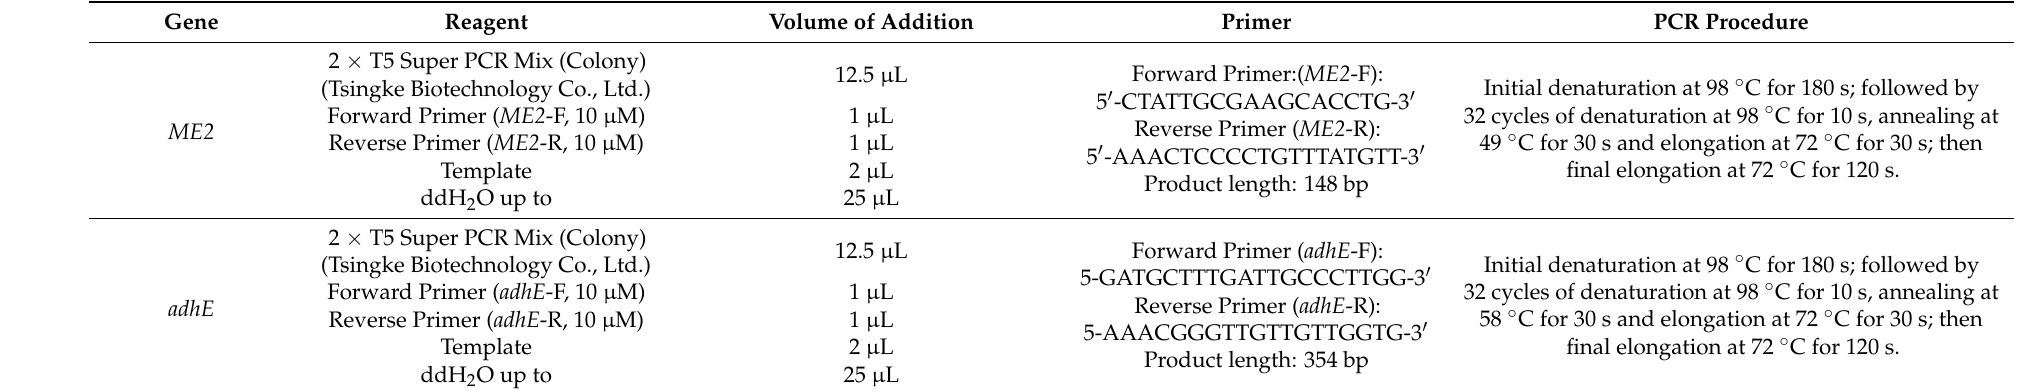
Table 1. Colony PCR reaction system and